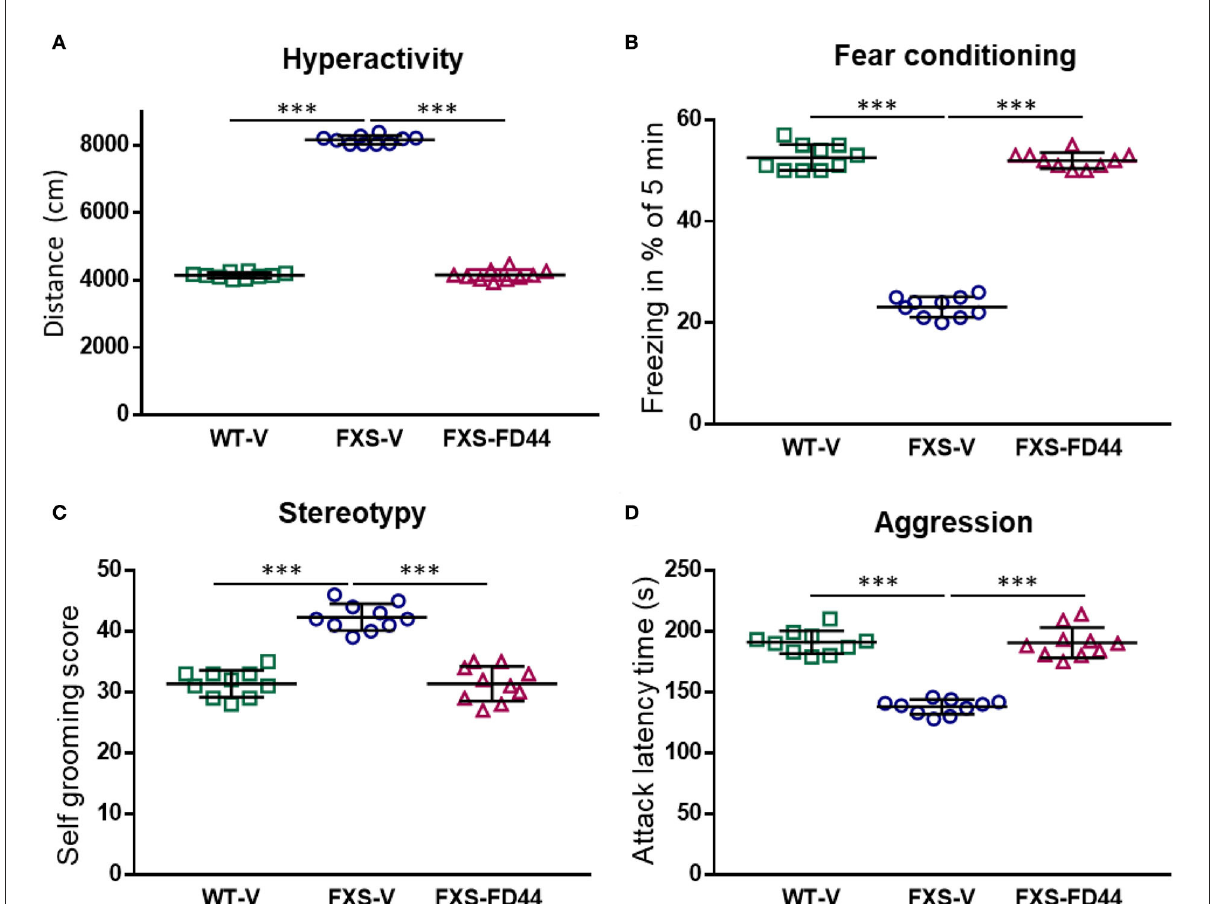
FIGURE3 FD44 effects on the behavior in fragile X mental retardation 1 (Fmr1) KO2 mice. Wild-type (WT) or Fmr1 KO2 [Fragile X syndrome (FXS)] adult mice were treated intraperitoneally with V or with 10 mg/kg of FD44, daily for 4 weeks and then subjected to a range of behavioral tests. FD44 treatment caused a significant improvement of Fmr1 KO2 phenotypes in (A) hyperactivity, measured by the distance traveled in the open field, (B) associative learning, measured by the freezing response after fear conditioning with an aversive stimulus, (C) stereotype revealed